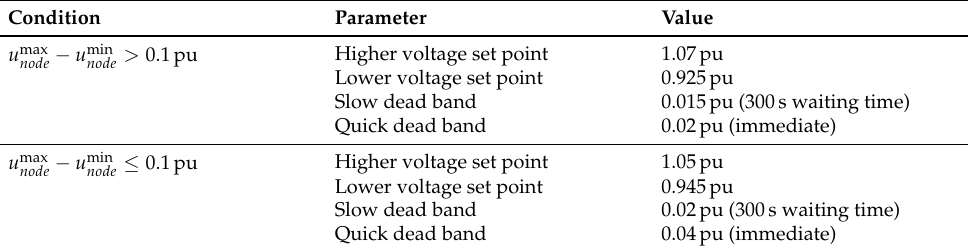
Table 3. Control parameters for the VRDT. Partially adapted from ref.